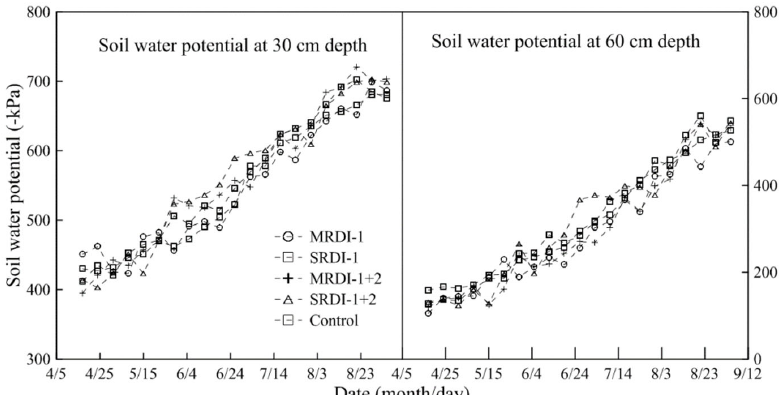
Figure 3. Soil water potential at 30 cm and 60 cm depth in non ‐ irrigated zone in 2010. MRDI ‐ 1 and SRDI ‐ 1 were applied with moderate and severe water stress, respectively, during Stage 1 (0–30 DAB), and fully irrigated during other stages; MRDI ‐ 1+2 and SRDI ‐ 1+2 were applied with moderate and severe water stress, respectively, during Stage 1+2 (0–86 DAB), and fully irrigated during other stages.